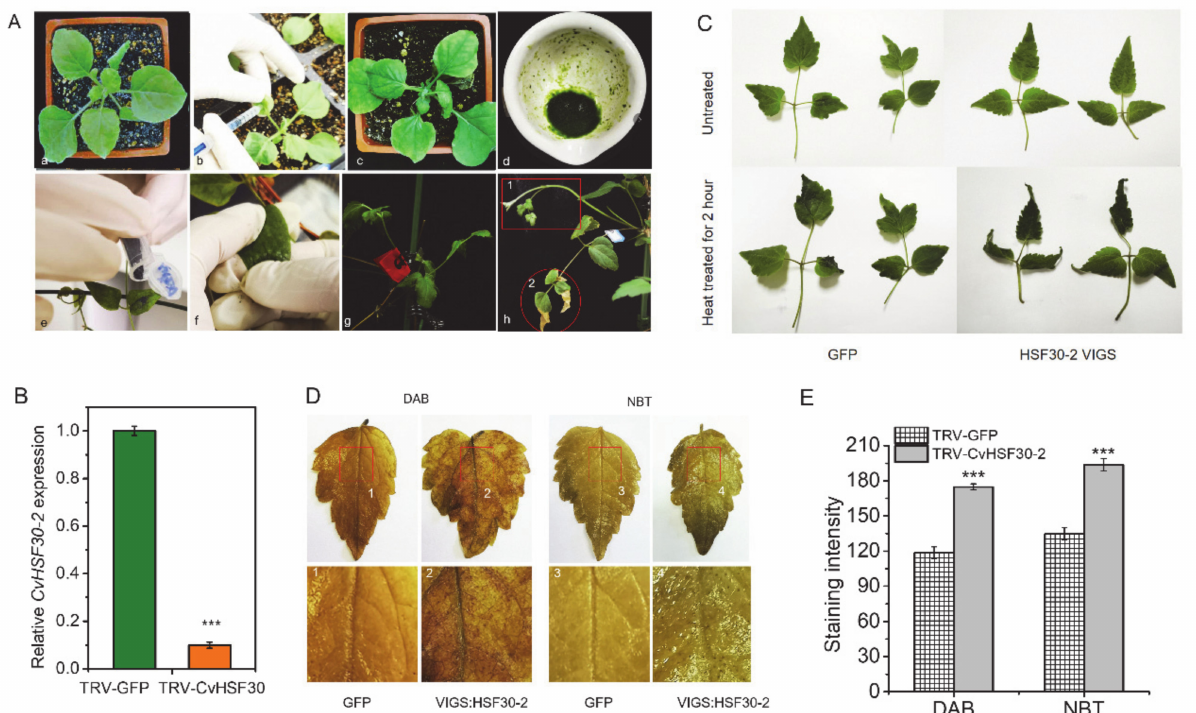
Figure 5. Silencing of CvHSF30-2 on Clematis. ( A ) Operation flow chart of VIGS in Cv. ( a – c ) Four-week-old tobacco, N. benthamiana , was injected with GV3101 harboring TRV2- CvHSF30-2 , and the leaves were taken three days later. ( d – f ) The leaves injected with TRV2-NBHSF30-2 virus were thoroughly ground. Then, juice was taken and placed on the clematis leaves with quartz sand added. The clematis leaves were inoculated by rubbing by hand. ( g , h ) The clematis inoculated by friction was marked and placed in a constant-temperature incubator for cultivation until new branches and leaves had grown. ( B ) Silencing effect of CvHSF30-2 in control (GFP) and virus-silenced (VIGS: HSF30-2) clematis leaves based on qPCR. ( C ) Heat-shock phenotype of CvHSF30-2- silenced Cv by VIGS. ( D ) Staining of Cv leaves after heat shock by DAB and NBT. DAB- and NBT-stained pictures of each group of clematis leaves; the parts of each picture marked with red squares and labelled 1, 2, 3 and 4 correspond to the enlarged pictures below. ( E ) DAB and NBT staining quantified using the ImageJ2x program. Error bars represent the standard error of three biological replicates. *** p <